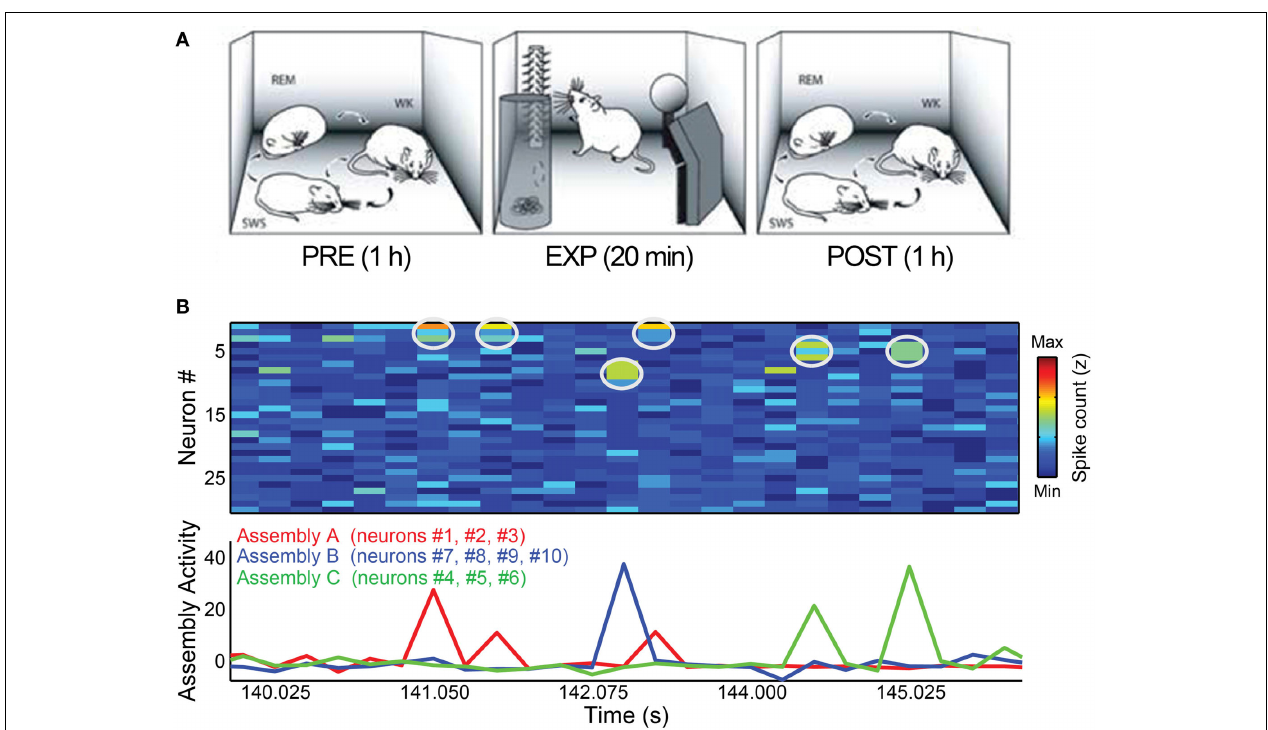
FIGURE 1 | Behavioral paradigm and cell assembly detection. (A) Rats were submitted to three periods of experimentation. During PRE and POST periods, animals were kept in a rectangular box freely behaving for 1h, including complete wake-sleep cycle, sorted here as WK, SWS, and REM. Within EXP period, 4 novel objects were placed in the corners of the box and the animals were free to explore them for 20min. Figure adapted from Ribeiro et al. (2007). (B) Toy example of assembly detection and projection of assembly activity time-series. We simulated 30 independent neurons as Poisson processes with mean 1 spike/bin and created three assemblies (A–C)